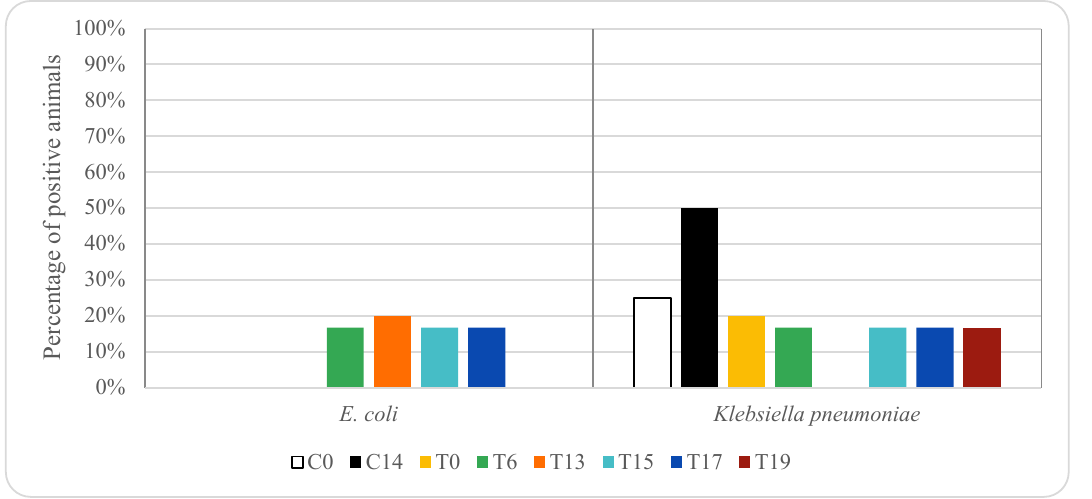
Figure 5. Effect of oxytetracycline treatment on ESBL-producing E. coli and K. pneumoniae in pig rectal samples. For group descriptions, C0, C14, T0, T6, T13, T15, T17 and T19: see Table 1.